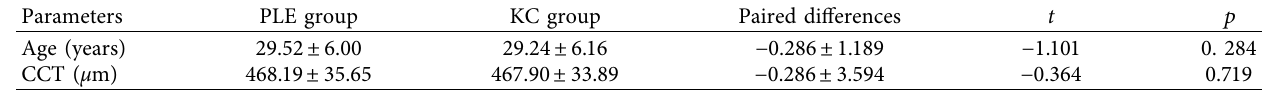
Table 2: Age and central corneal thickness comparison between PLE and KC